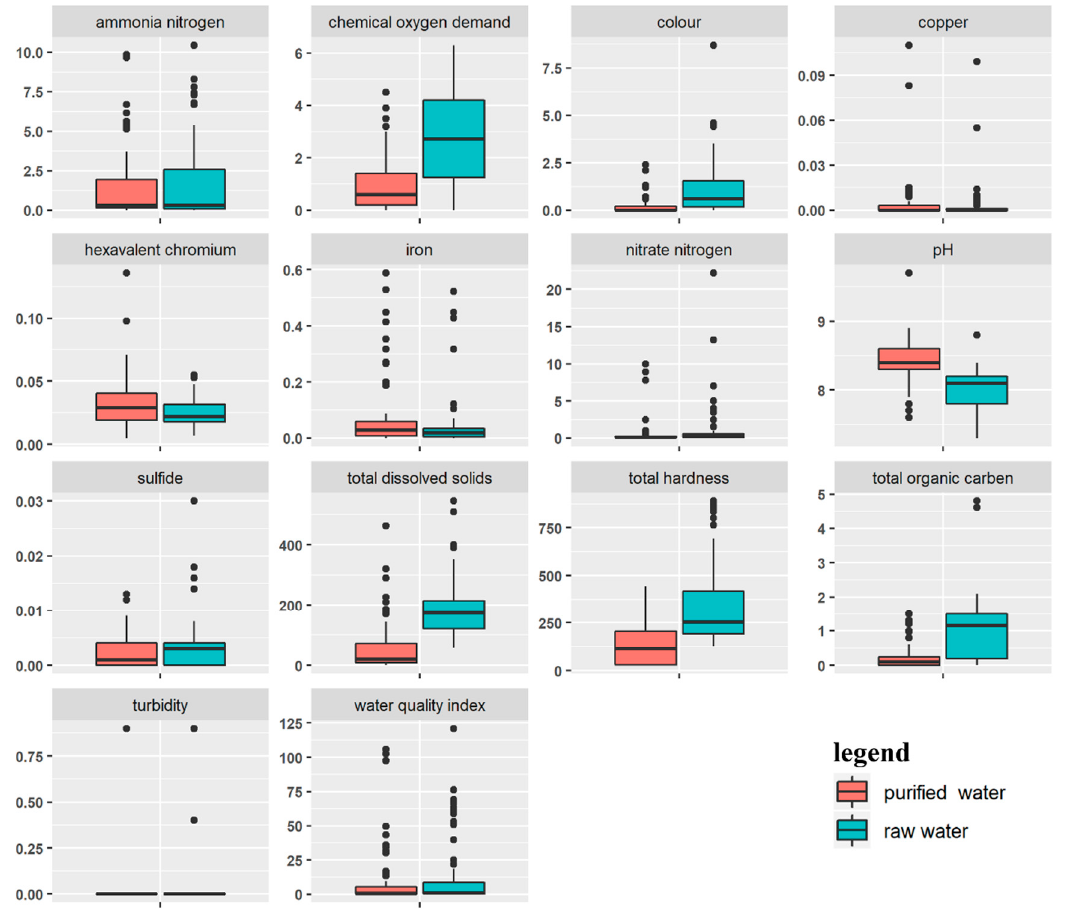
Figure 3. Water quality parameters in the raw and purified water samples ( n = 67). Units: color (TCU), turbidity (NTU), ammonia nitrogen (mg/L N), nitrate nitrogen (mg/L N), chemical oxygen demand (COD) (mg/L O 2 ), total hardness (mg/L CaCO 3 ), water quality index and pH (standard units), and other parameters (mg/L).